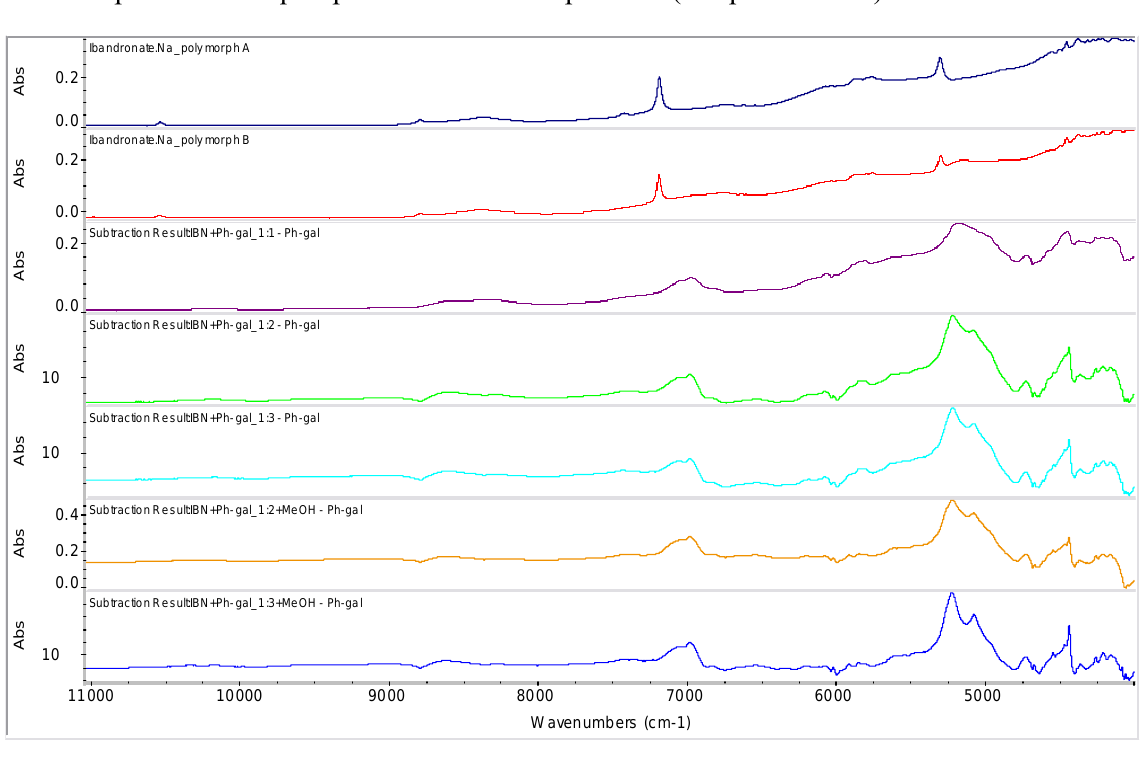
Figure 10. NIR spectra of ibandronate (IBN) monosodium salt forms A and B and subtracted spectra of potential co-crystals of IBN+Ph-gal in ratios 1:1, 1:2 and 1:3 (samples 1 - 3 ) and potential co-crystals in ratios 1:2 and 1:3 prepared by addition of MeOH and evaporation of liquid part at ambient temperature (samples 6 and 7